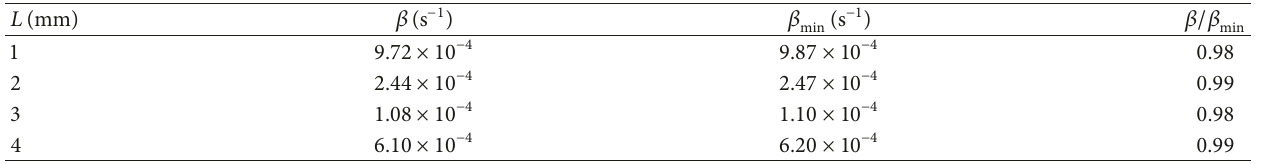
Table 1: The comparison between the 𝛽 fitted by 𝑃(𝑡) ∼ 𝑒 −𝛽𝑡 and the 𝛽 min of (6). 𝐿